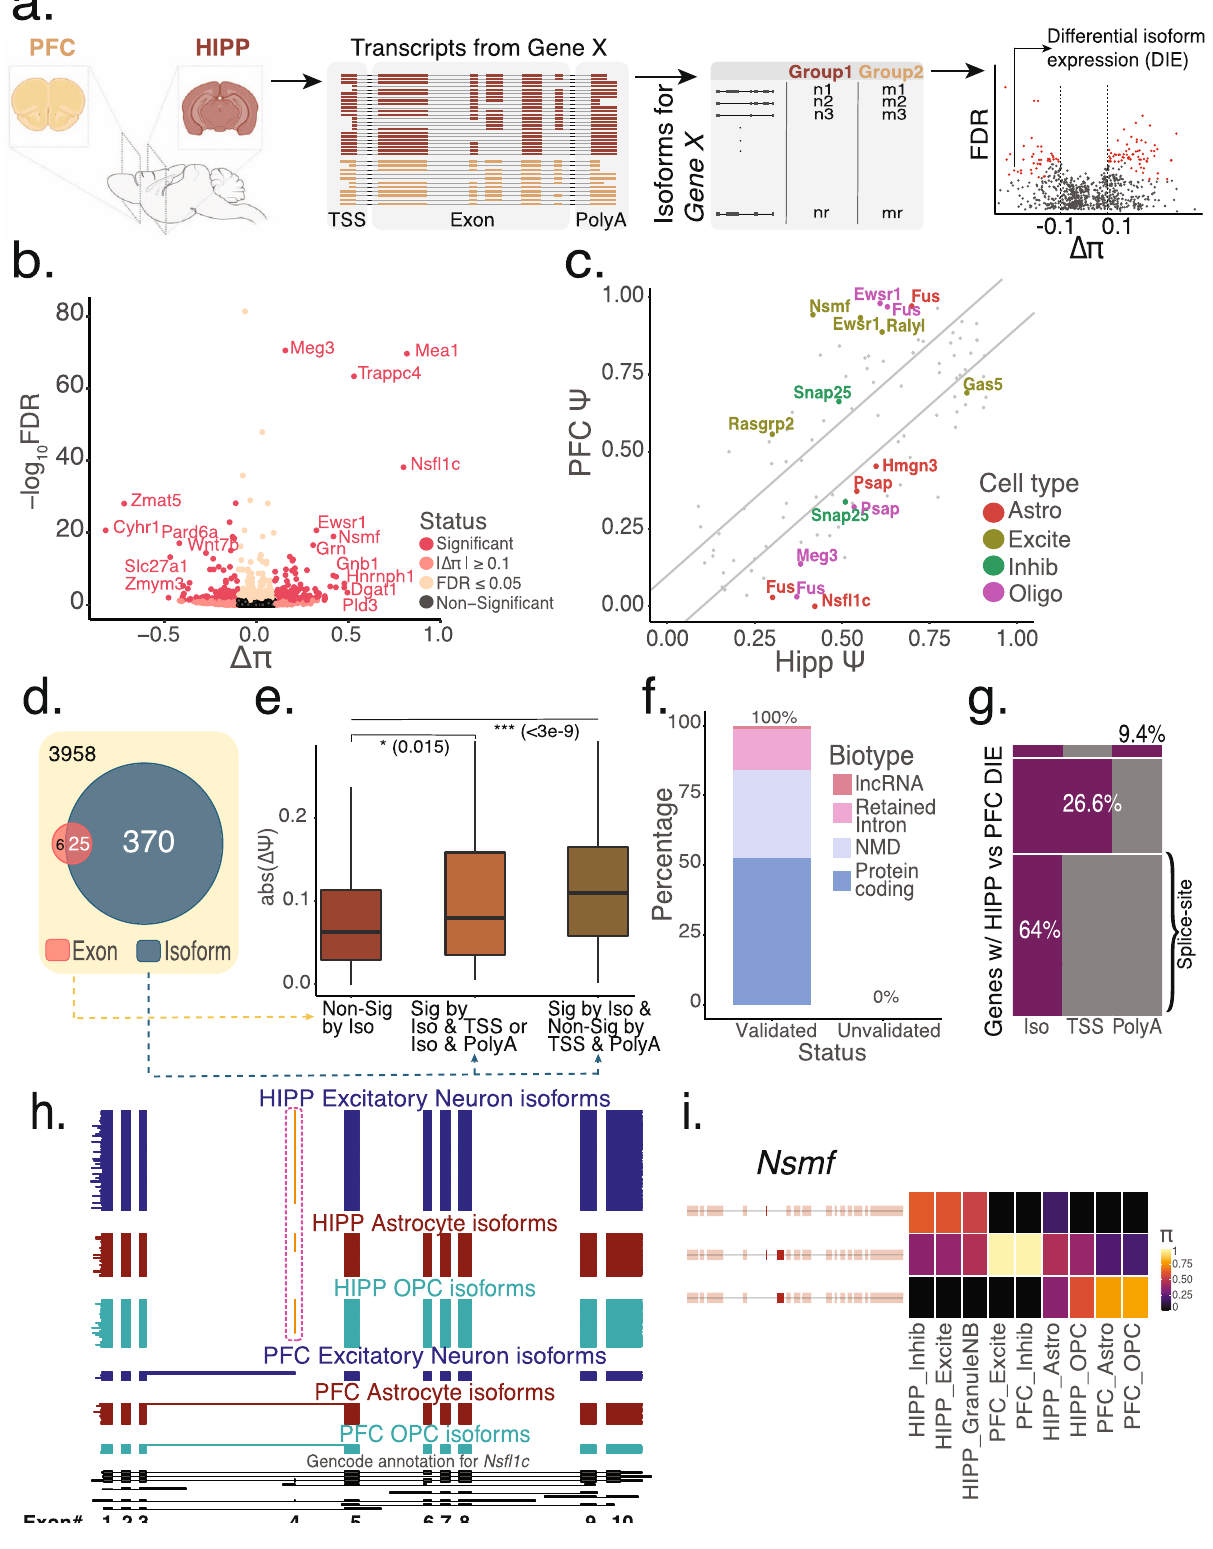
Differential isoform expression across brain regions is gov- erned predominantly by one speci fi c cell type . Gene expression transcript similarities among clusters de fi ned a cell-type hier- archy, fi rst separated by neurons and non-neurons, and then by other cell types (Fig. S6). Since inhibitory neuron types are transcriptionally more similar to each other than to